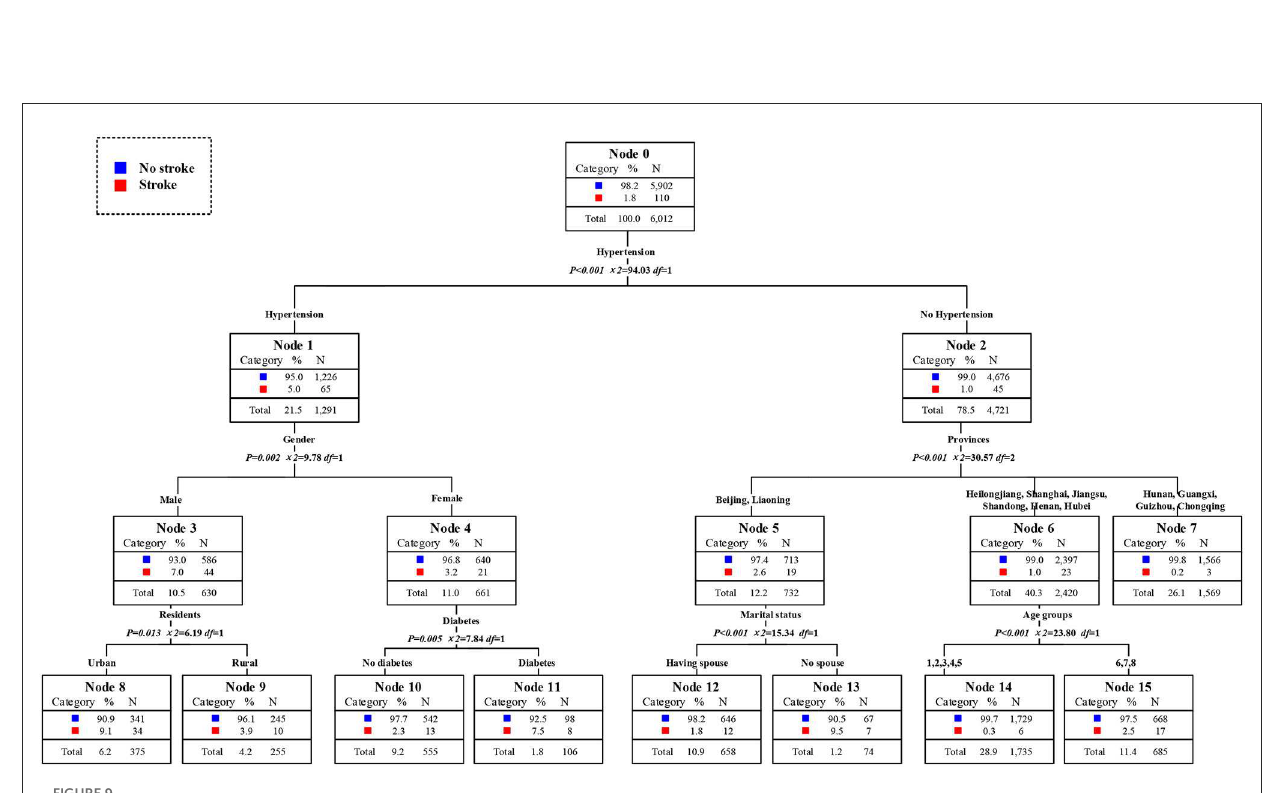
FIGURE9 Assessment of risk factors and the susceptible population of stroke in